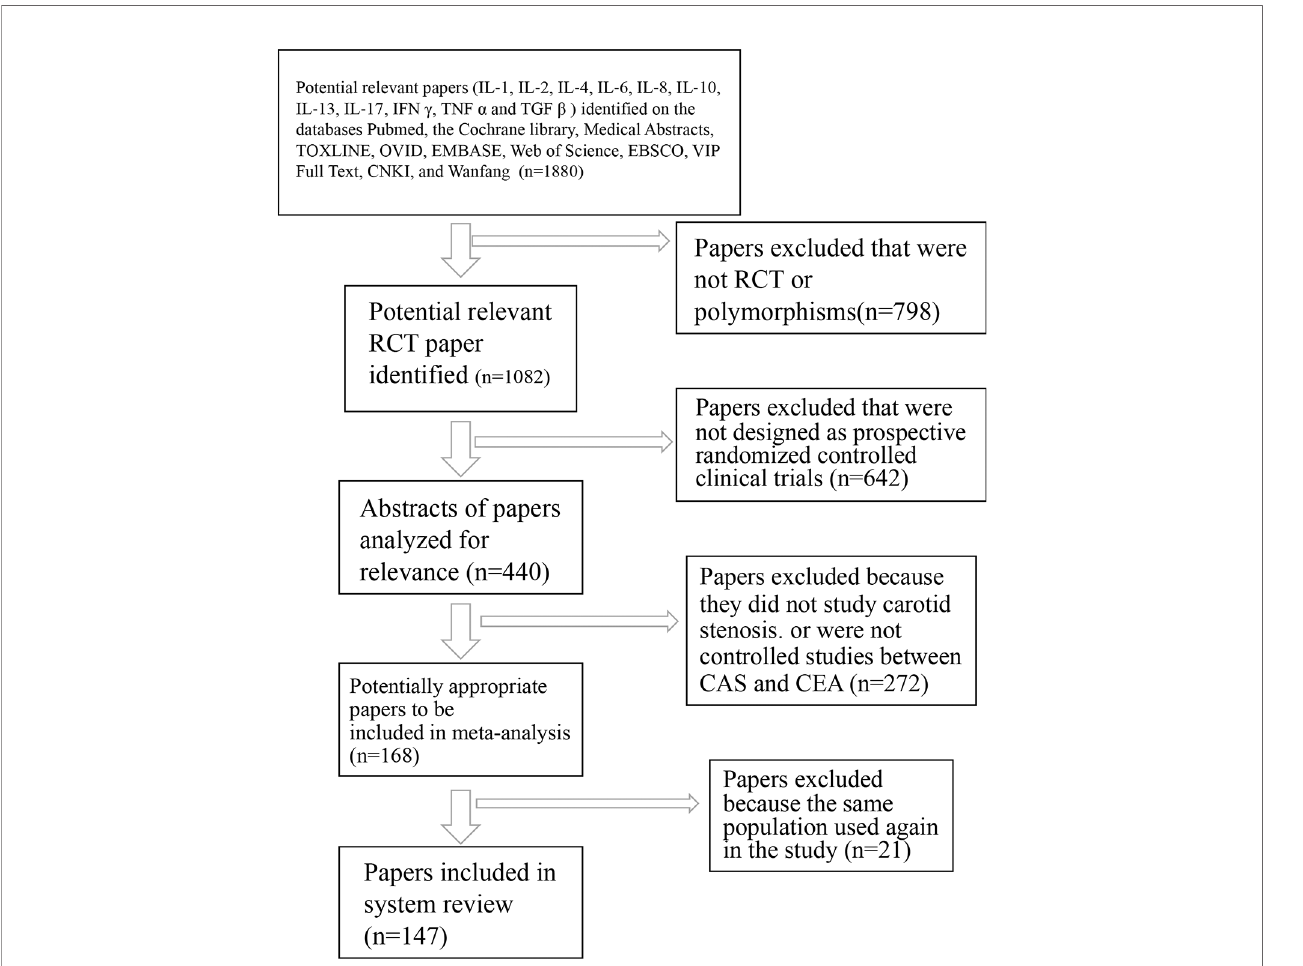
FIGURE 1 | Flowchart of trial search and selection for meta-analysis. RCT, randomized and controlled trial; IL ‐ 1, interleukin ‐ 1; IL ‐ 2, interleukin-2; IL ‐ 4, interleukin ‐ 4; IL ‐ 6, interleukin ‐ 6; IL ‐ 8, interleukin ‐ 8; IL ‐ 10, interleukin-10; IL ‐ 13, interleukin ‐ 13; IL ‐ 17, interleukin ‐ 17; IFN- g , interferon gamma; TNF- a , tumor necrosis factor alpha; TGF- b , transforming growth factor